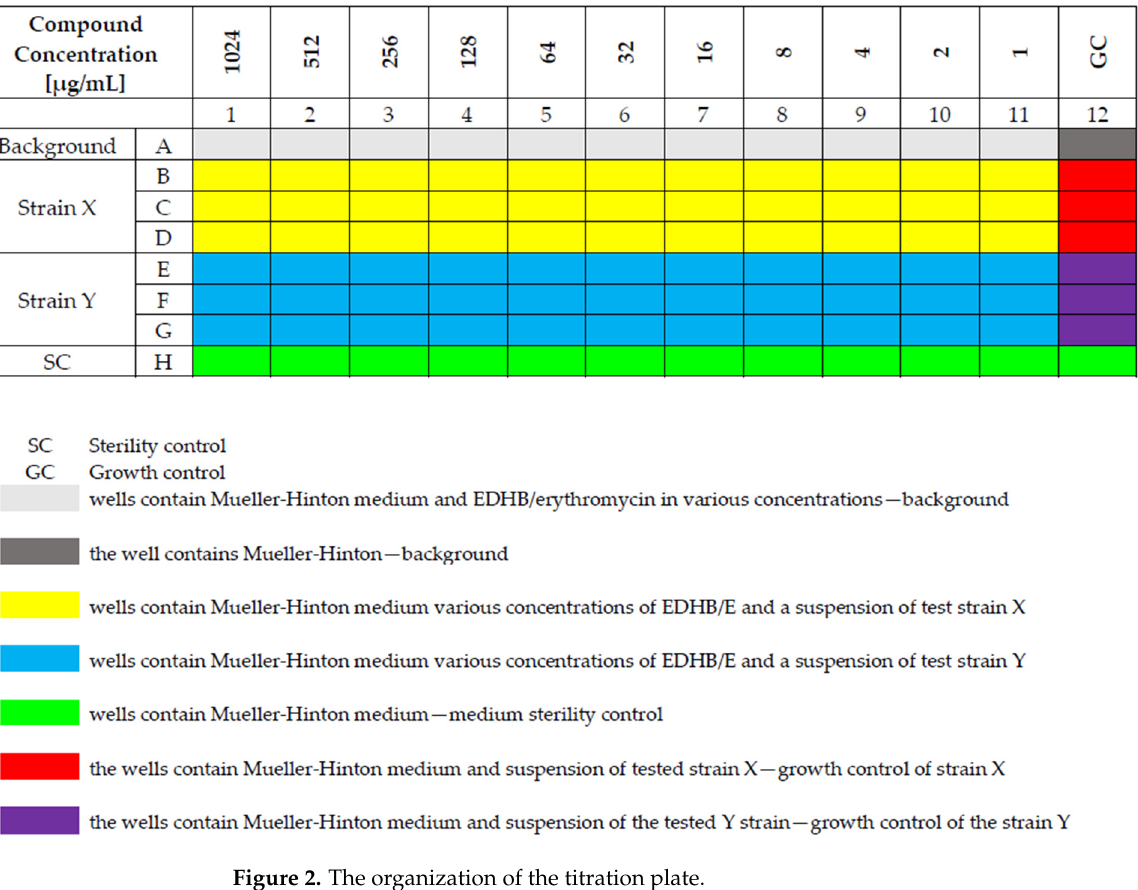
Figure 2. The organization of the titration